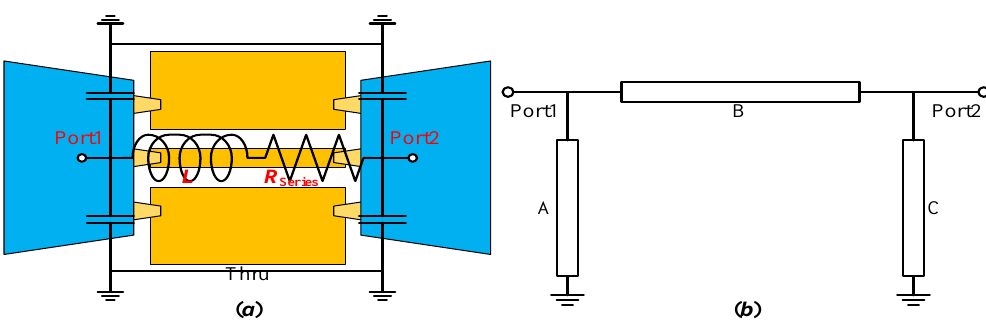
Figure 6. The equivalent circuit of delay line. (a) equivalent circuit, (b) π -shaped model.